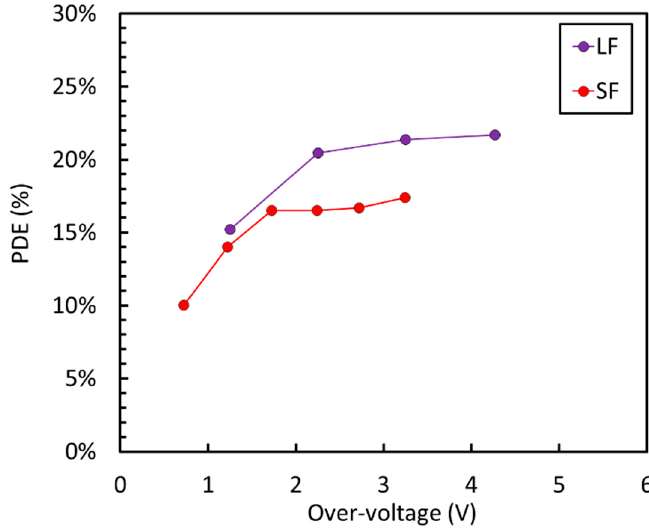
Figure 25. PDE at 175 nm, measured on VUV-HD SiPM with 35 µm cell size in LXe. Measures taken from Reference [41].